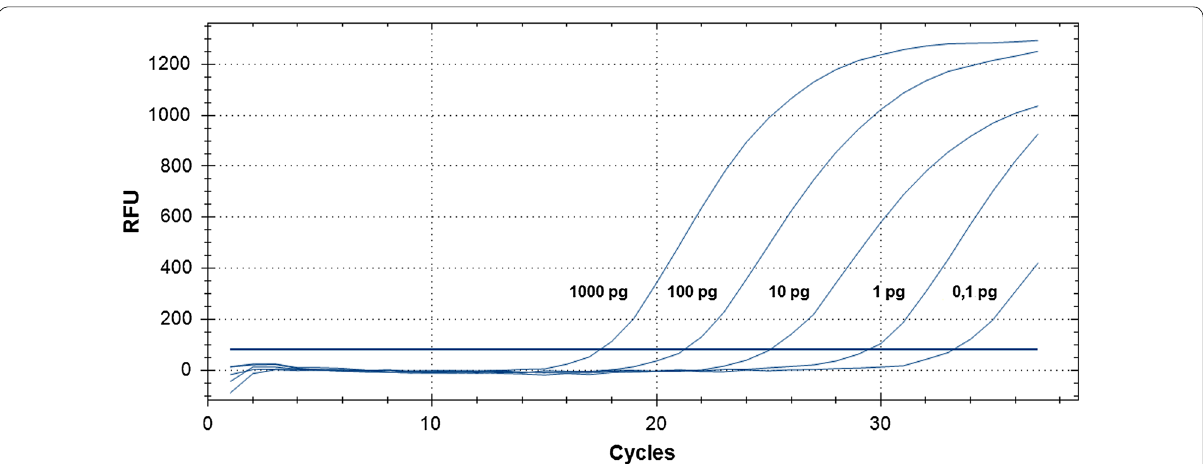
Fig. 3 The influence of different amount of P. kudriavzevii genomic DNA per reaction and Cq